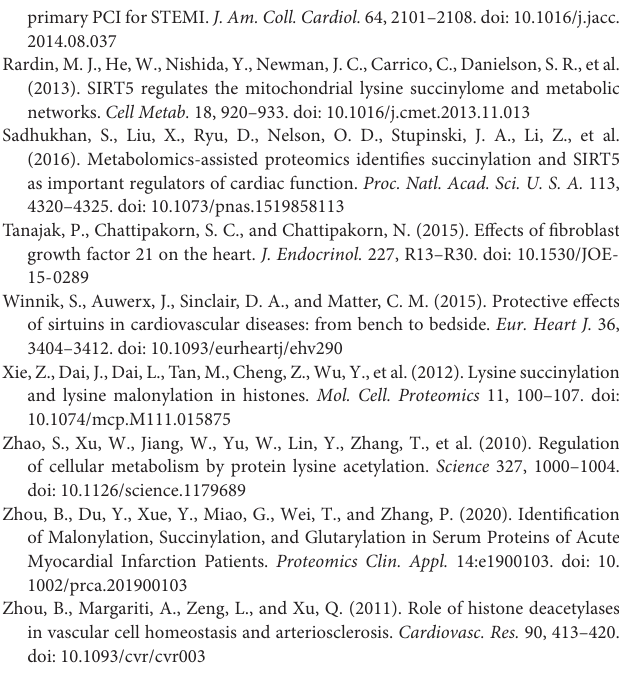
Supplementary Figure 1 | Western blot analysis of SIRT5 in the kidney, brain, and heart of WT mice and Liver SIRT5 OE mice ( n = 3). Supplementary Figure 2 | Comparation of heart function before AMI. (A) Representative images of echocardiography before AMI between Liver SIRT5 OE and WT mice ( n = 8). (B) Comparation of heart function before AMI between Liver SIRT5 OE and WT mice ( n = 8). Supplementary Figure 3 | Detection of FGF21 in WT mice and Liver SIRT5 OE mice. (A) Western blot analysis of FGF21 in the muscle of WT mice and Liver SIRT5 OE mice ( n = 3). (B) Primary hepatocytes were isolated from Liver SIRT5 OE or WT mice, and cultured in vitro . FGF21 protein was detected in the culture medium by ELISA and compared. Supplementary Figure 4 | Sample preparation for LC-MS analysis of hepatic mitochondria ( n = 8): A total of eight WT c57 mice and eight Liver SIRT5 OE mice were subject to starvation for 12 h before experiment, then hepatic mitochondria were isolated from every four mice and processed as one sample in